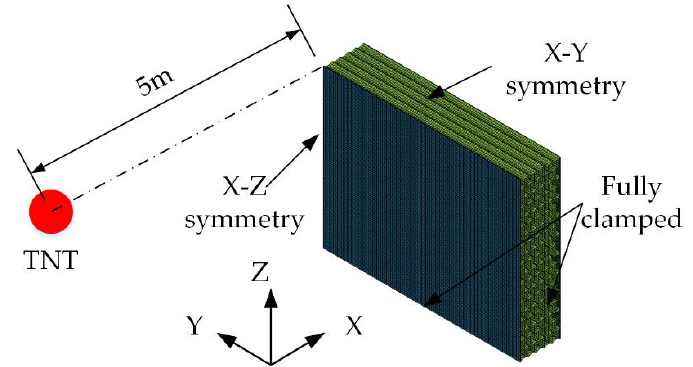
Figure 5. Diagram of TNT position and boundary conditions.